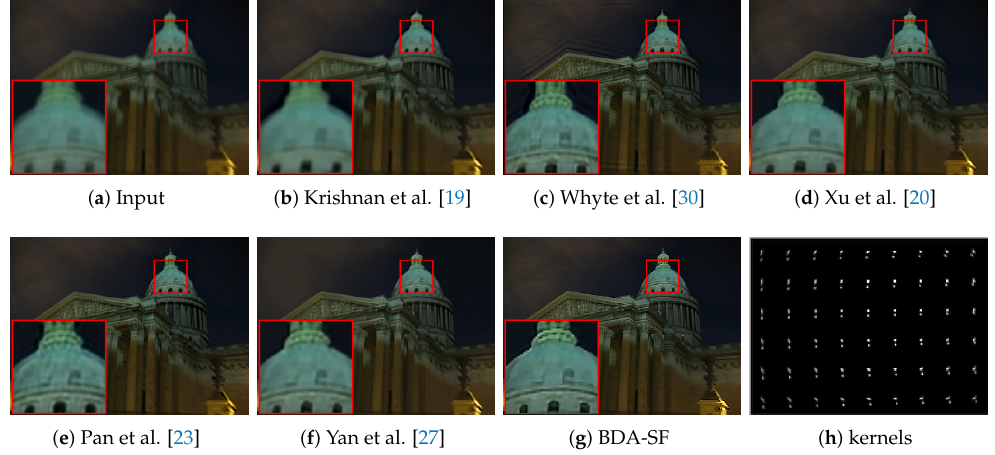
Figure 19. Visual comparison on images with non-uniform blur. Kernels are resized for visualiza- tion. BDA-SF is visually comparable to methods [20]. Method [23] contains ringing artifacts and residual